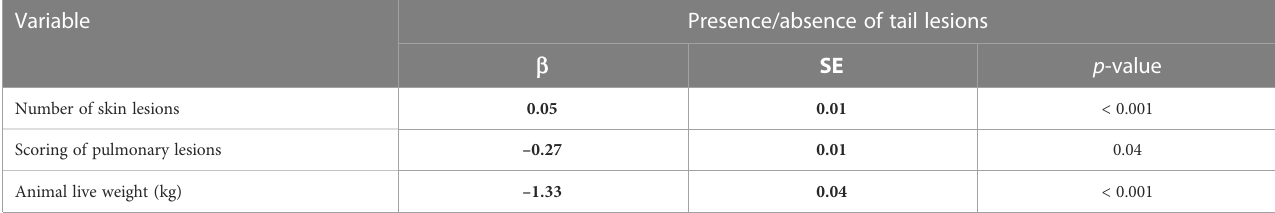
TABLE 5 Results from a multilevel mixed-effects logistic regression model of the relationship between presence/absence of tail lesions and antemortem and postmortem indicators of animal welfare in fattening pigs in a Colombian slaughterhouse. Variable